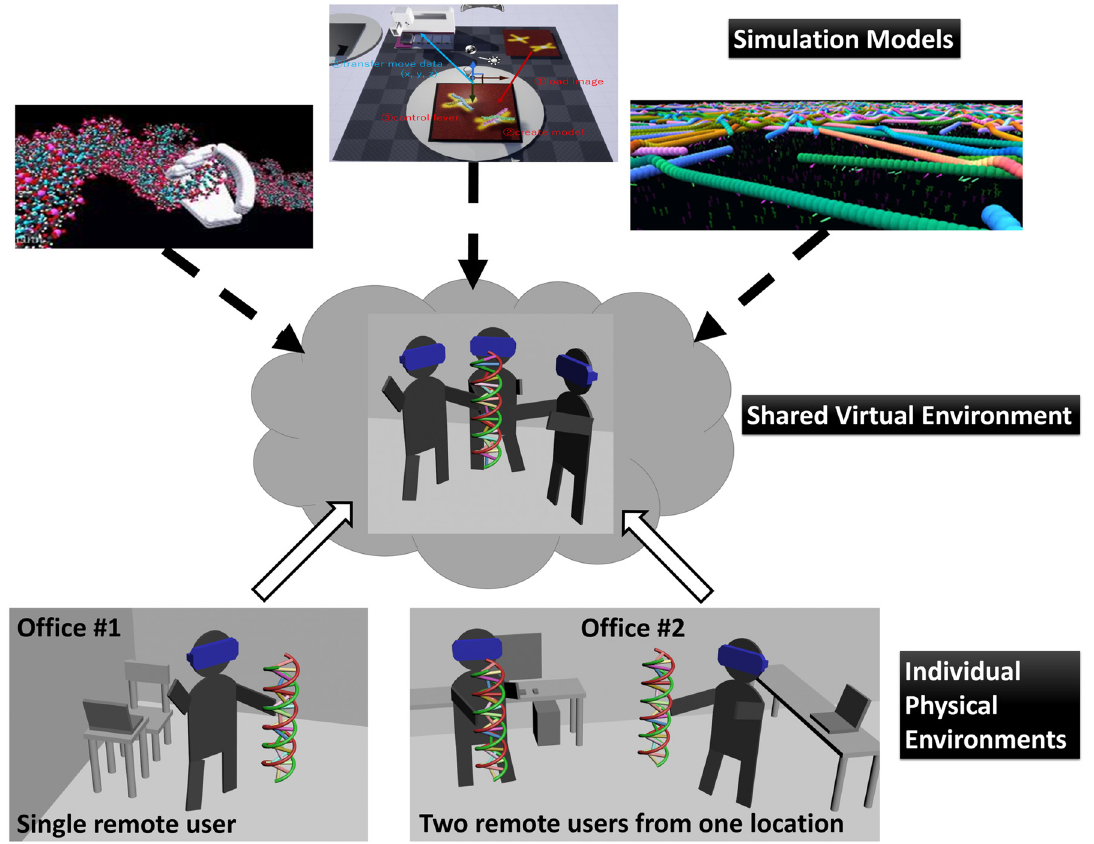
Figure 3: Conceptual design of